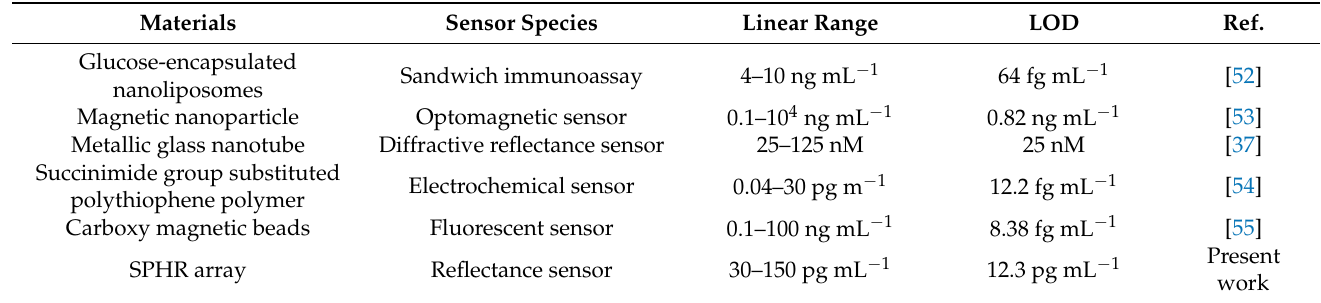
Table 4. Comparison of biosensors used for Y. pestis